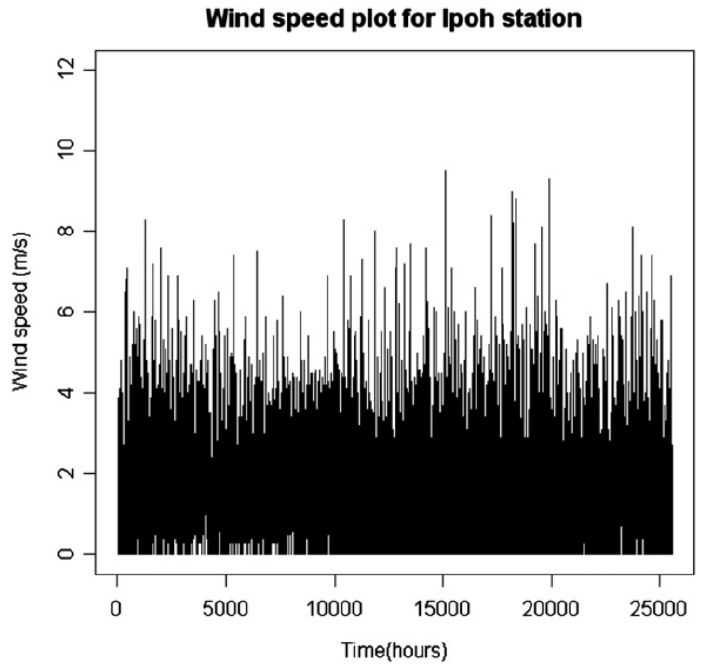
Figure 5. Wind speed trend at Ipoh wind station, Perak [10].